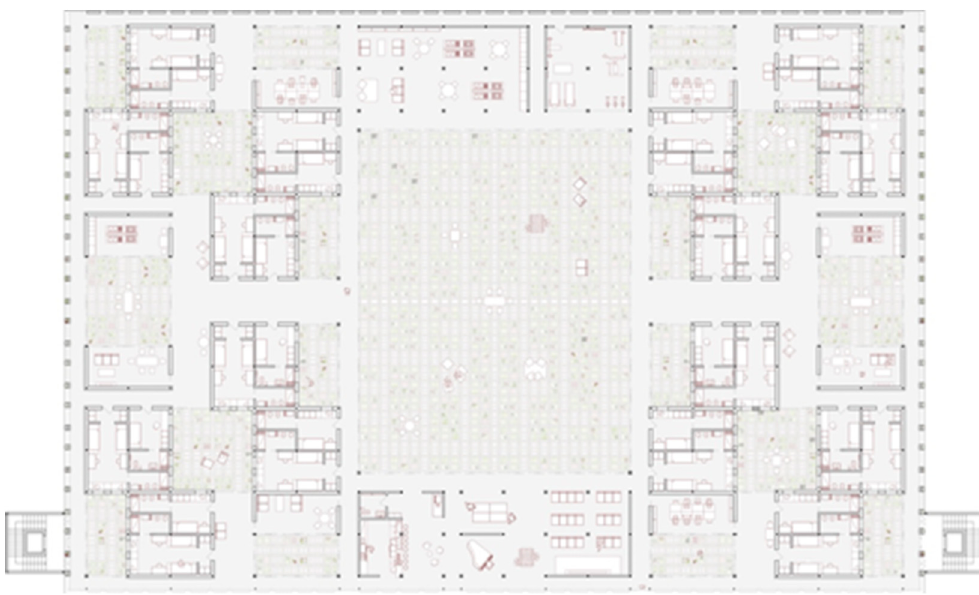
Figure 4. Plan of the whole building supra-elevated floor—architectural configuration. The opened central courtyard is located at the center of the whole floor [12].